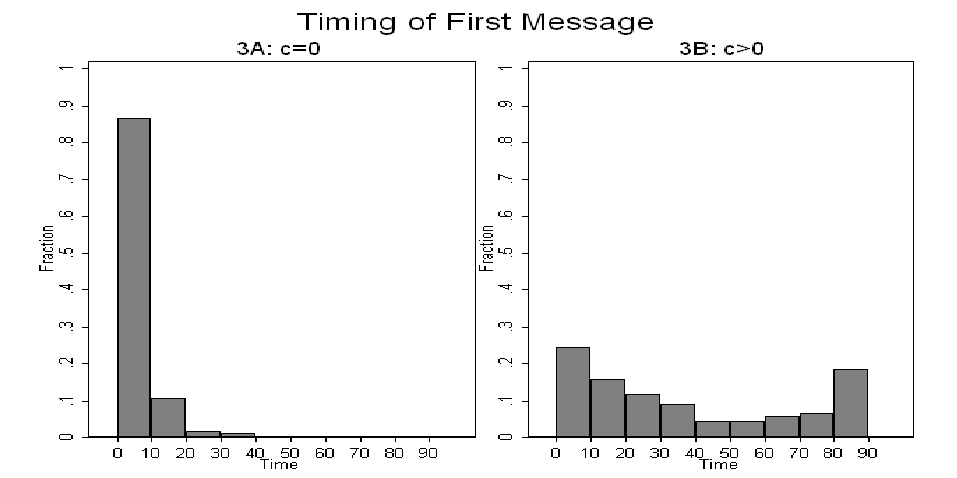
Figure 3. Distributions (in seconds) of the times to the first message. ( 3A ) uses data from zero cost treatments; ( 3B ) uses data from treatments with strictly positive communication cost.